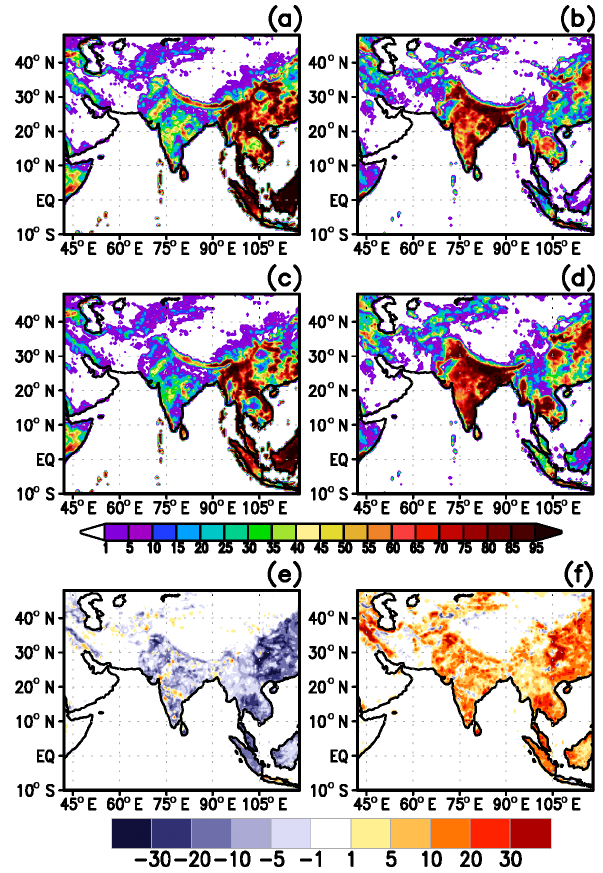
Figure 1. PFT distribution of forest and crop cover (in %) used as fixed lower boundary condition in the model experiments. (a) Forest and (b) crop of the year 1950 (HLC). (c) Forest and (d) crop of the year 2005 (PLC). Differences (PLC–HLC) in (e) forest and (f) crop cover.